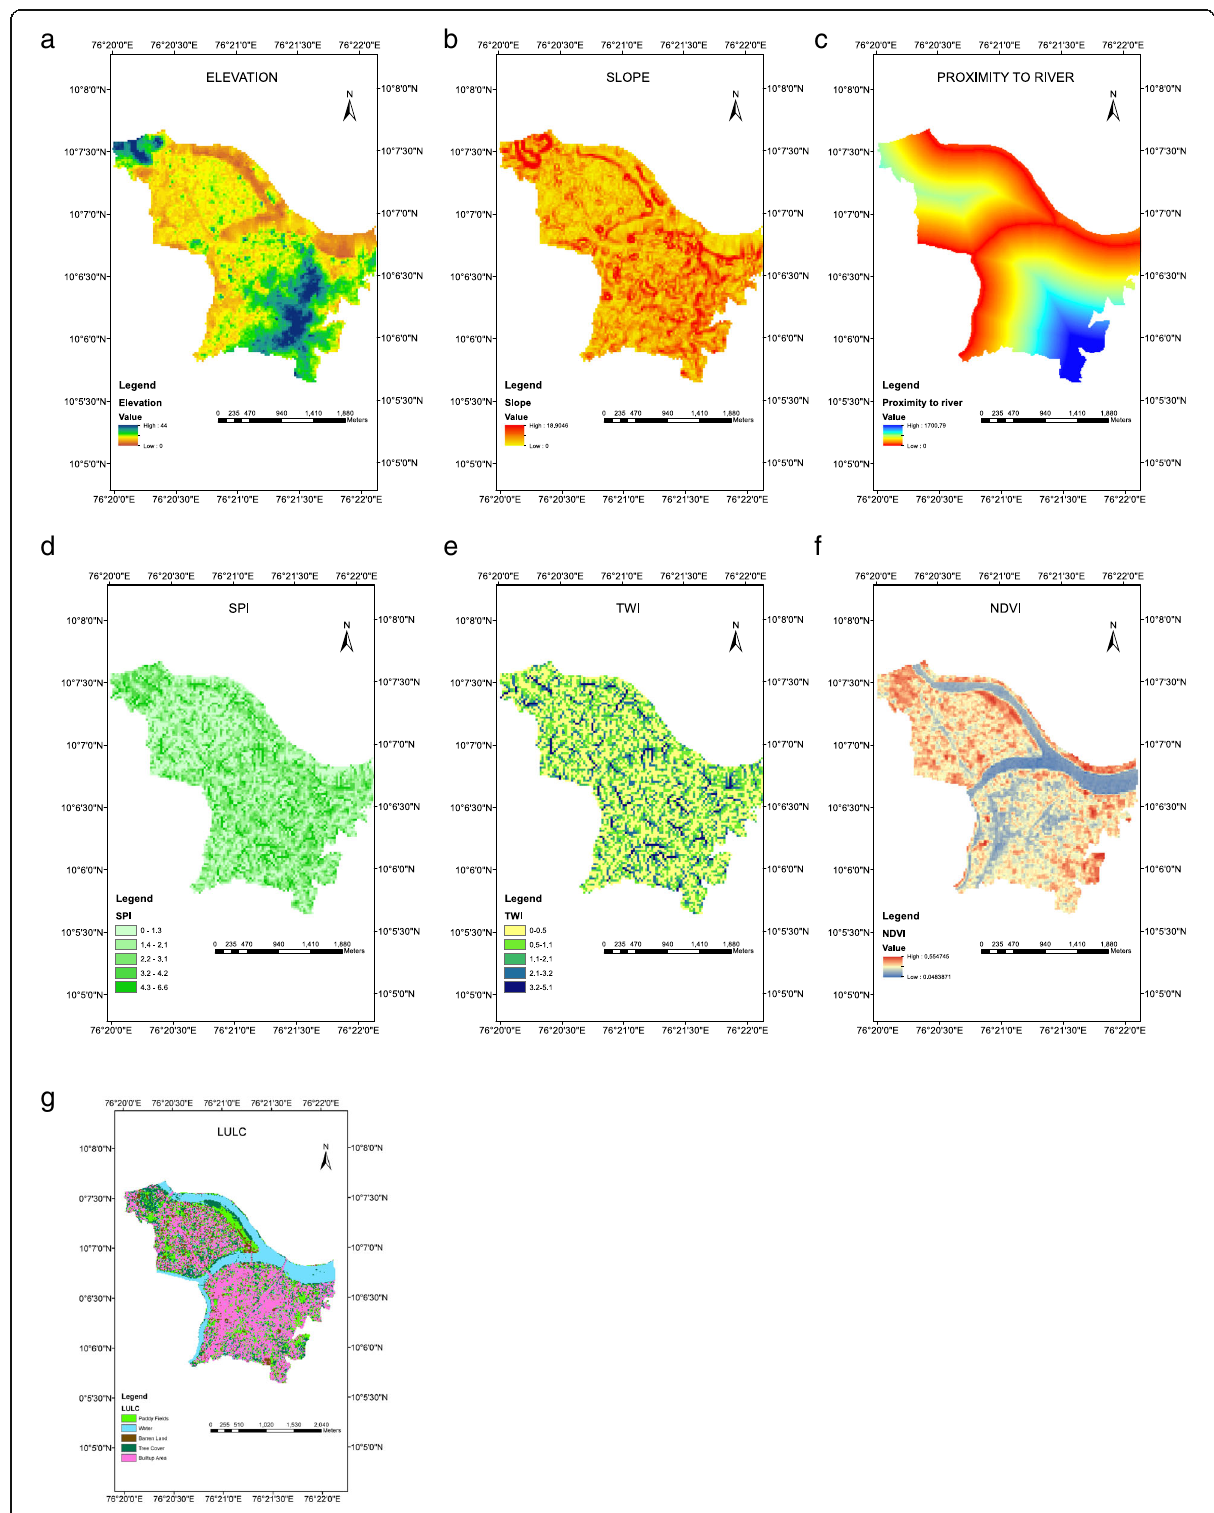
Fig. 6 Raster maps created for factors: a Elevation b slope c proximity to river d SPI e TWI f NDVI g